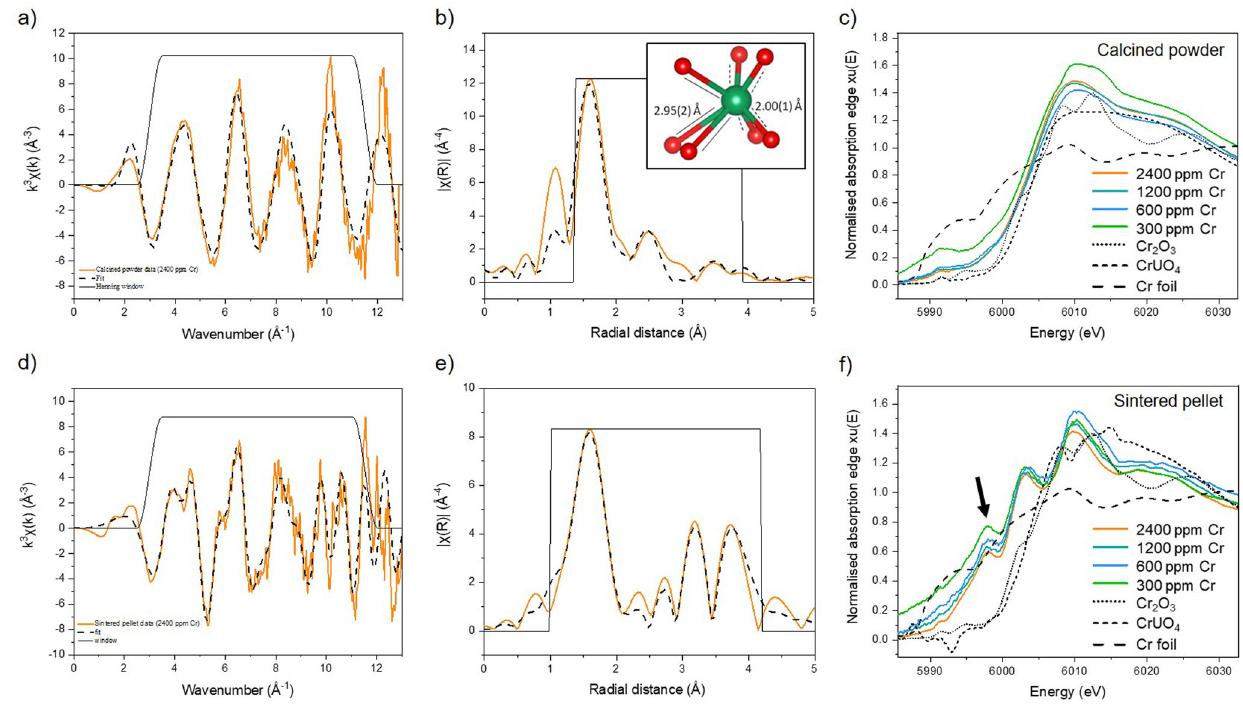
Fig. 2 Crystal structure and local coordination analysis of Cr in Cr-doped UO 2 determined by EXAFS and XANES analysis. k 3 -weighted Cr K-edge spectra, EXAFS model fi ts and Cr K-edge XANES spectra of Cr-doped UO 2 in comparison to known standards (Cr 2 O 3 , CrUO 4 and Cr 0 foil), respectively, for ( a – c ) calcined powders; and ( d – f ) sintered pellets. For ( a , b , d , e ) orange lines are data and black dashed lines are the fi